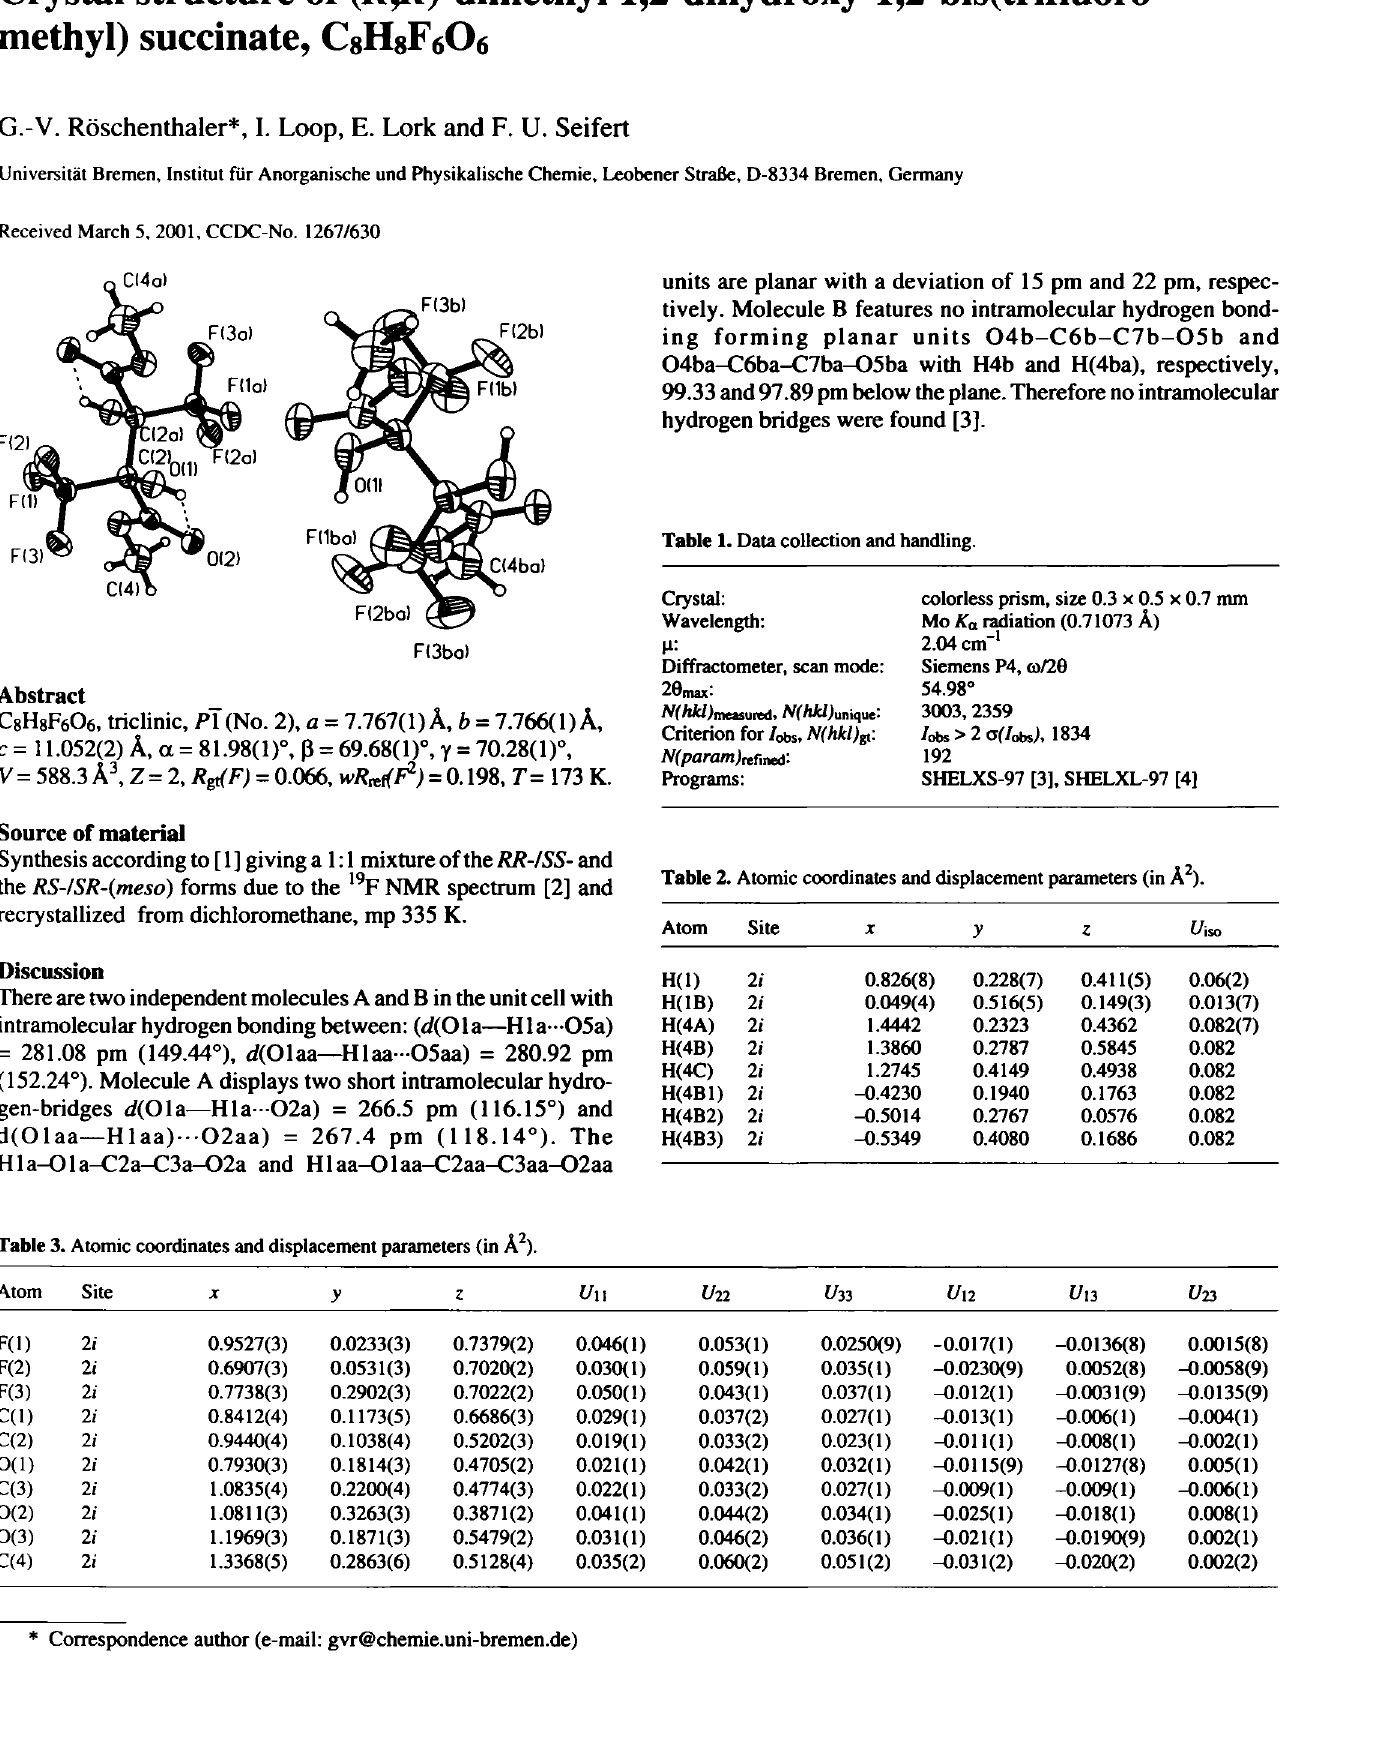
Table 3. Atomic coordinates and displacement parameters (in A 2